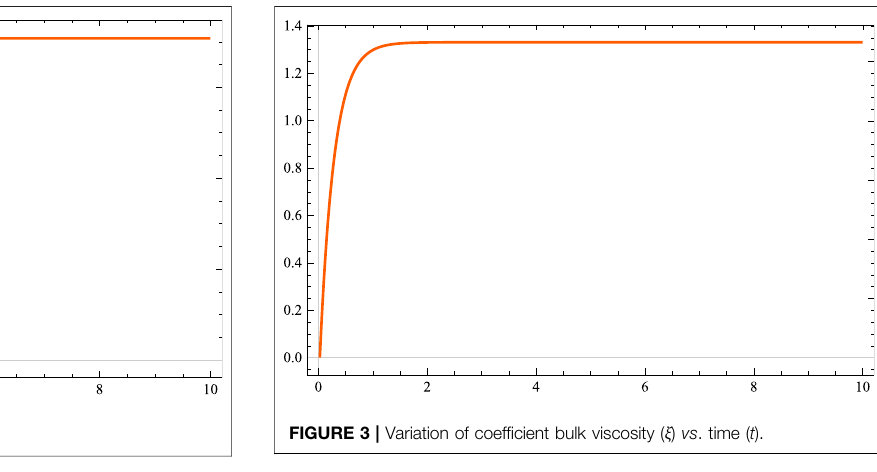
FIGURE 3 | Variation of coef fi cient bulk viscosity ( ξ ) vs . time ( t ).